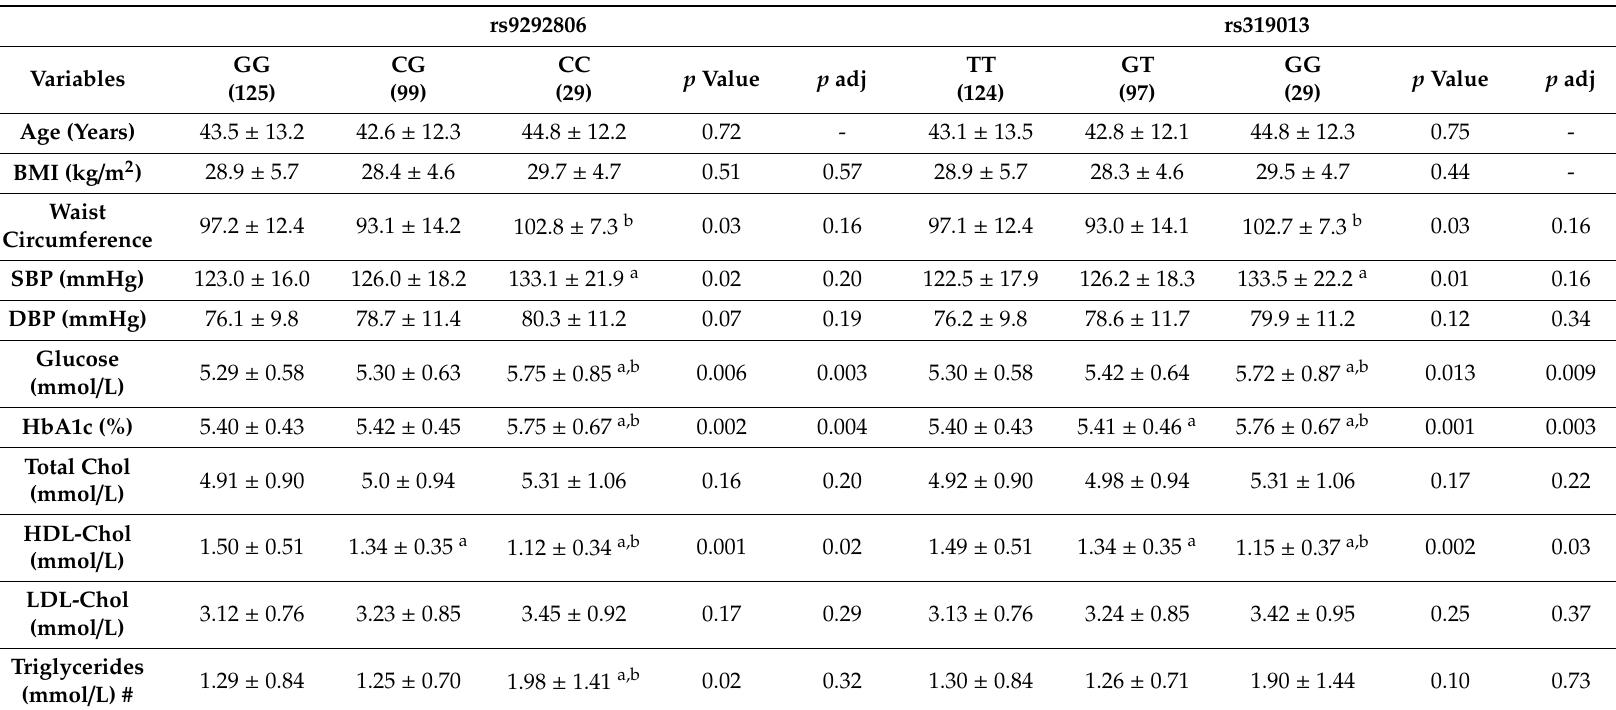
Table 5. Distribution of anthropometric and biochemical parameters according to PLCXD3 SNPs in control participants ( n =